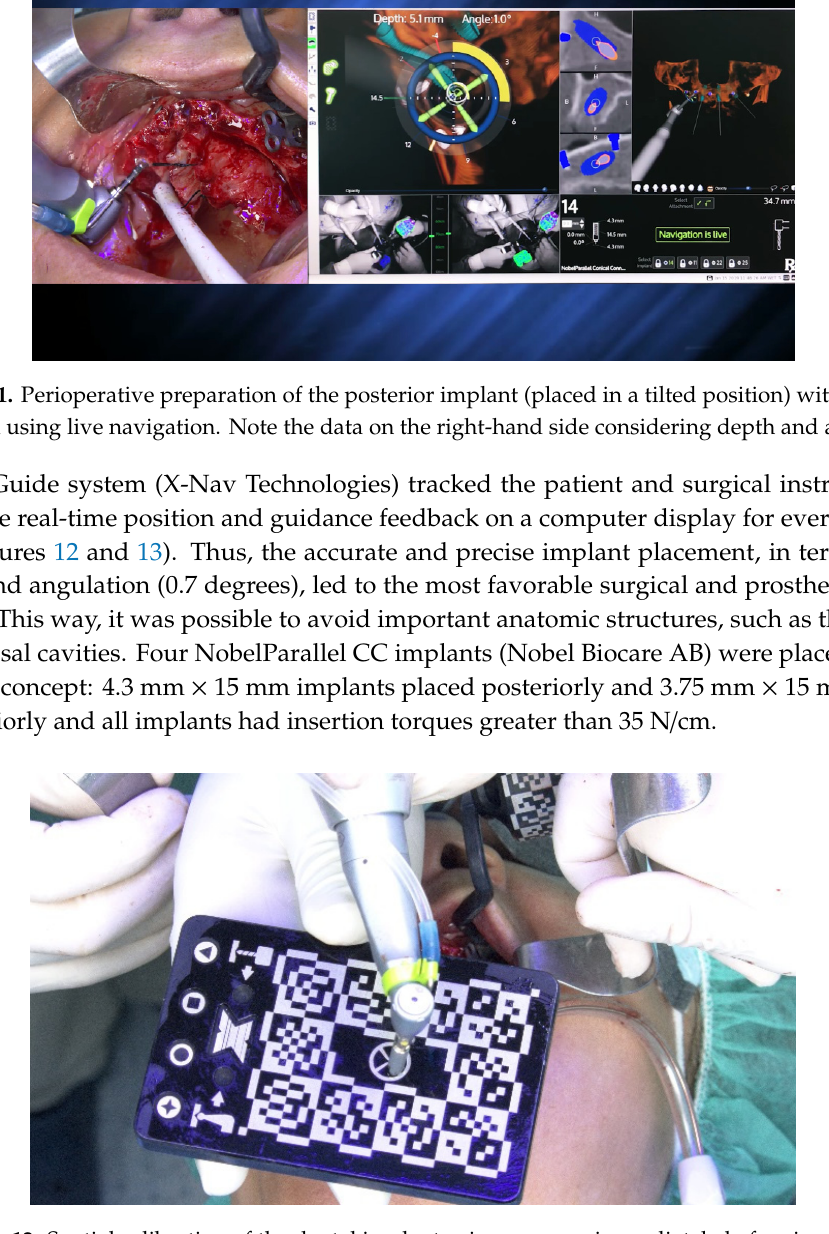
Figure 10. Spatial calibration of the 2.0 mm drill using an array immediately before the preparation.